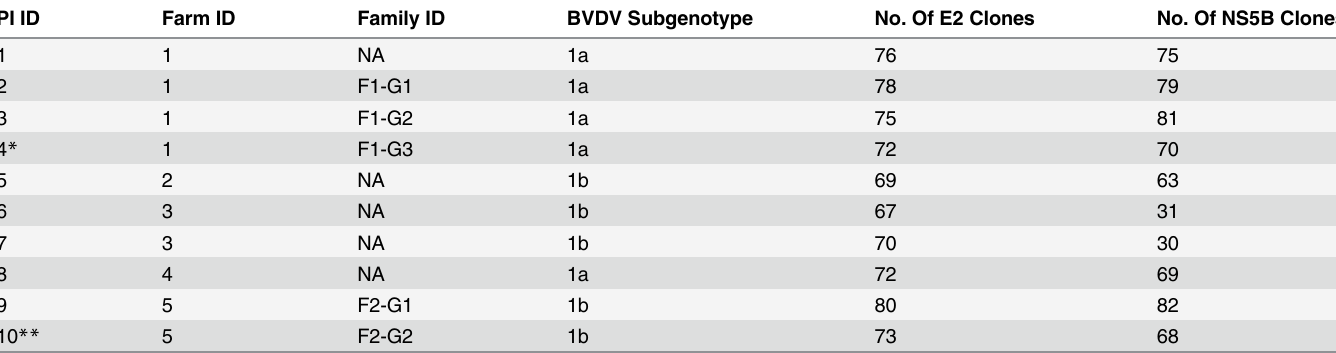
Table 1. Summary of all cattle included in the study as well as the data generated from clonal sequencing.